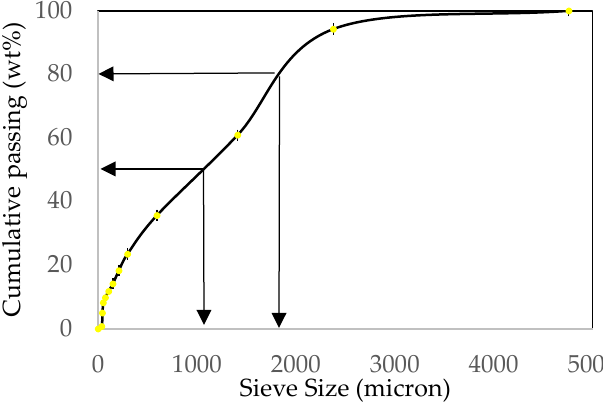
Figure 1. Size distribution of shredded printed circuit boards